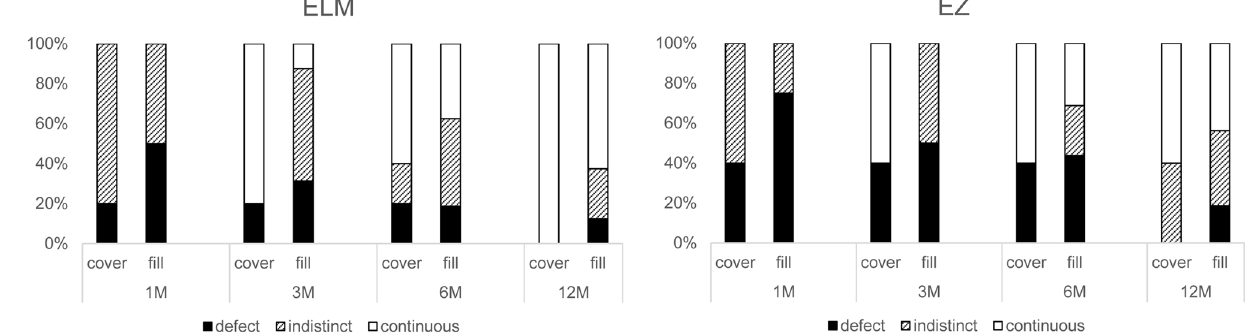
Figure 4. Recovery of the external limiting membrane (ELM) and ellipsoid zone EZ) in the cover group and the fill group at 1, 3, 6, and 12 months after